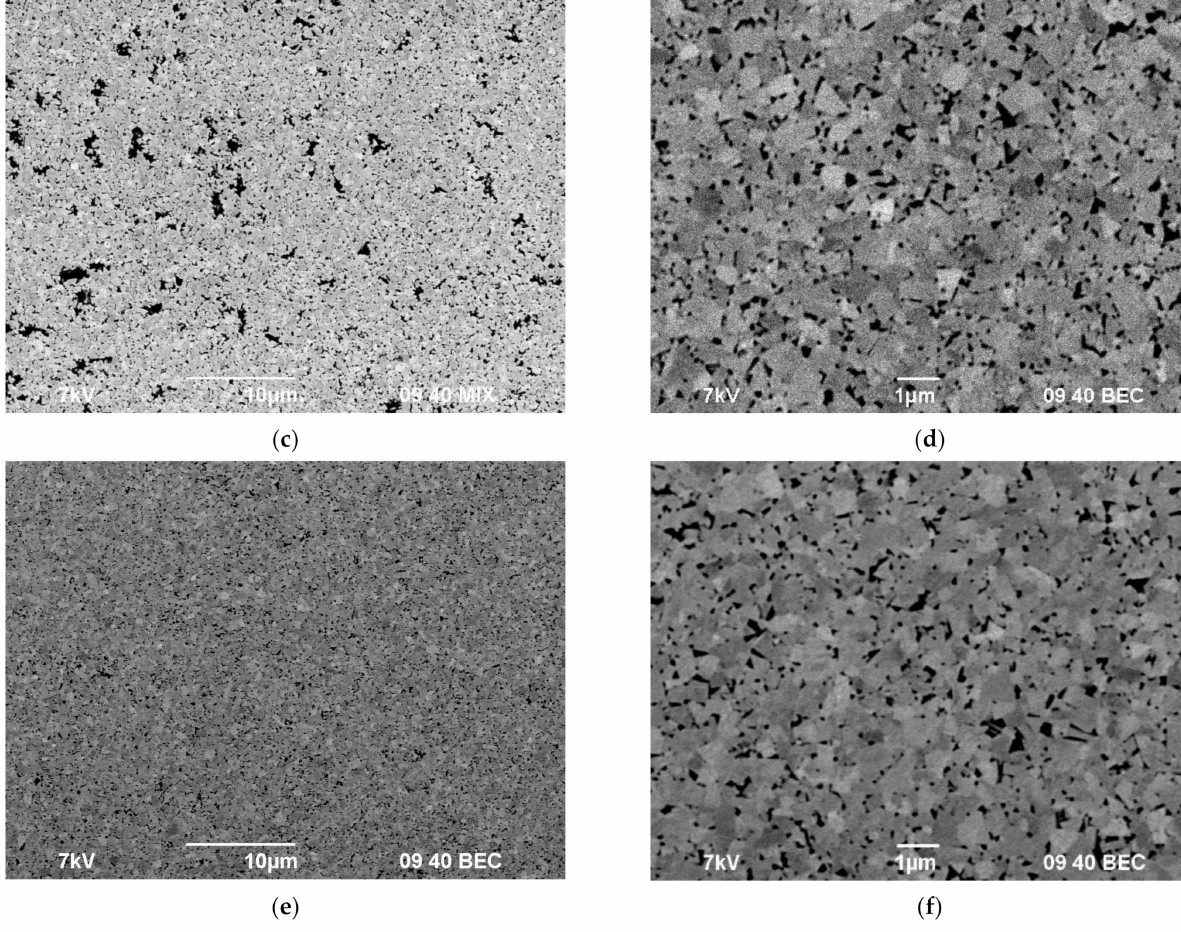
Figure 4. Microstructure of WC-10Co hard alloys obtained by solid-phase SPS without additional graphite ( a , b ), with 0.3 wt.% ( c , d ) and with 0.5 wt.% ( e , f ) of graphite.